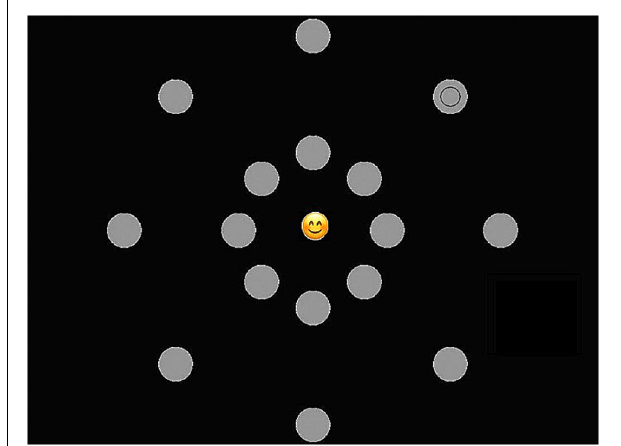
FIGURE 1 | Central Emoji and target stimulus of the attentional breadth task. Note: based on Van Beveren et al. (2020).